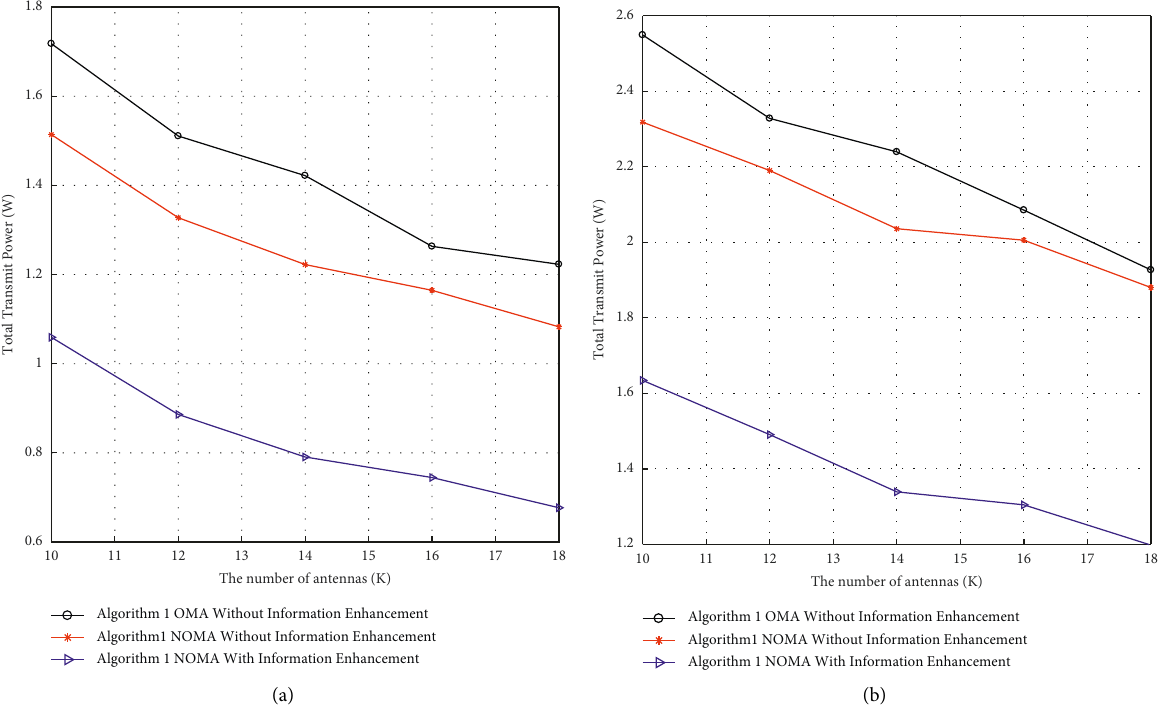
Figure 3: The optimal total transmission power versus the number of transmit antennas, with c � 1 and η � 1.